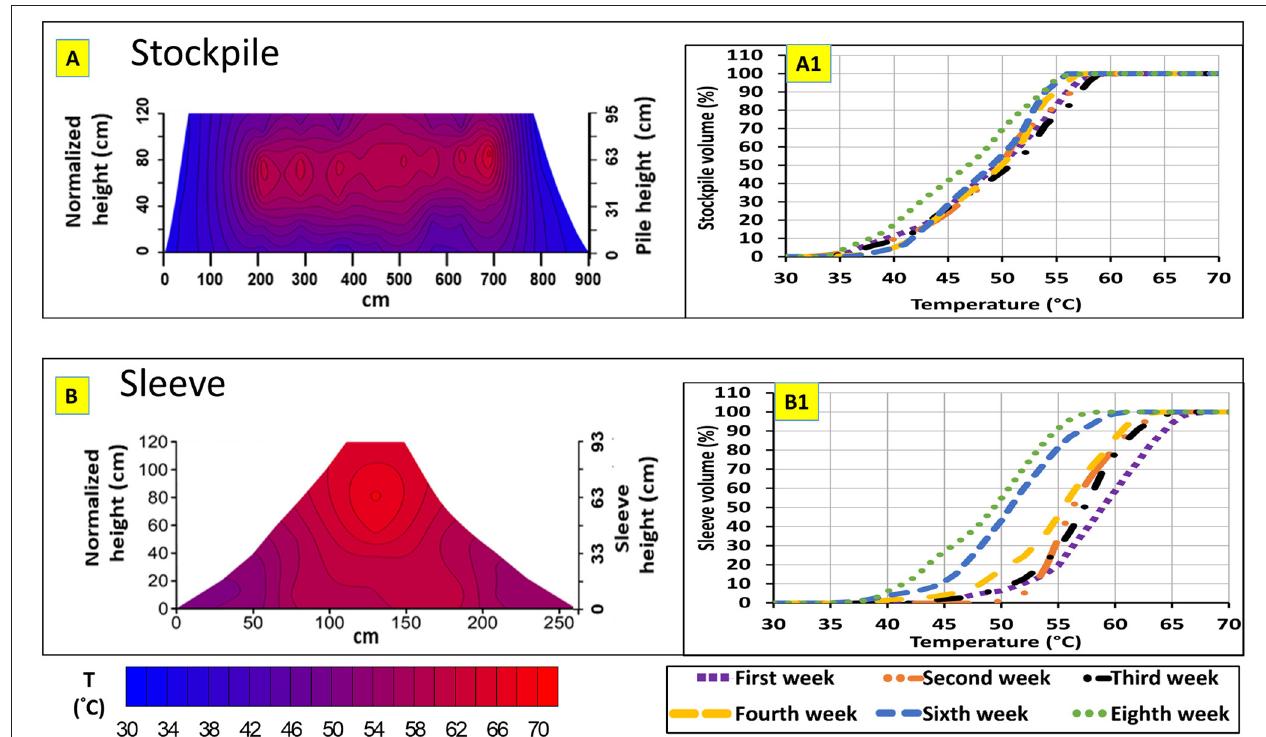
FIGURE 2 | Spatial–temporal variation in temperature ( ◦ C). Contour maps (week 1) and the cumulative volumetric percentage of temperature in the stockpile (A,A1) and the sleeve ( B ; cross-section II, B1 ; weighted average of cross-sections